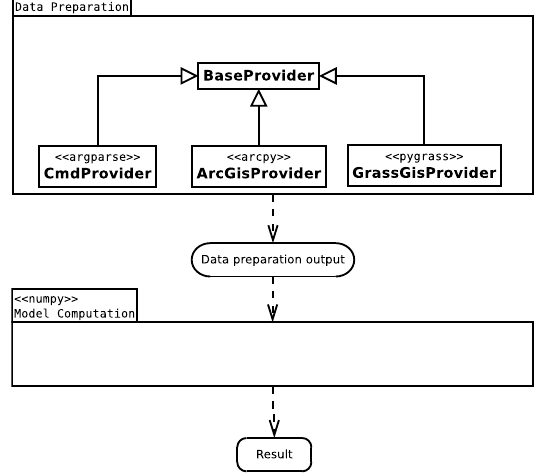
Figure 2. Concept of GIS providers (software dependencies outlined by